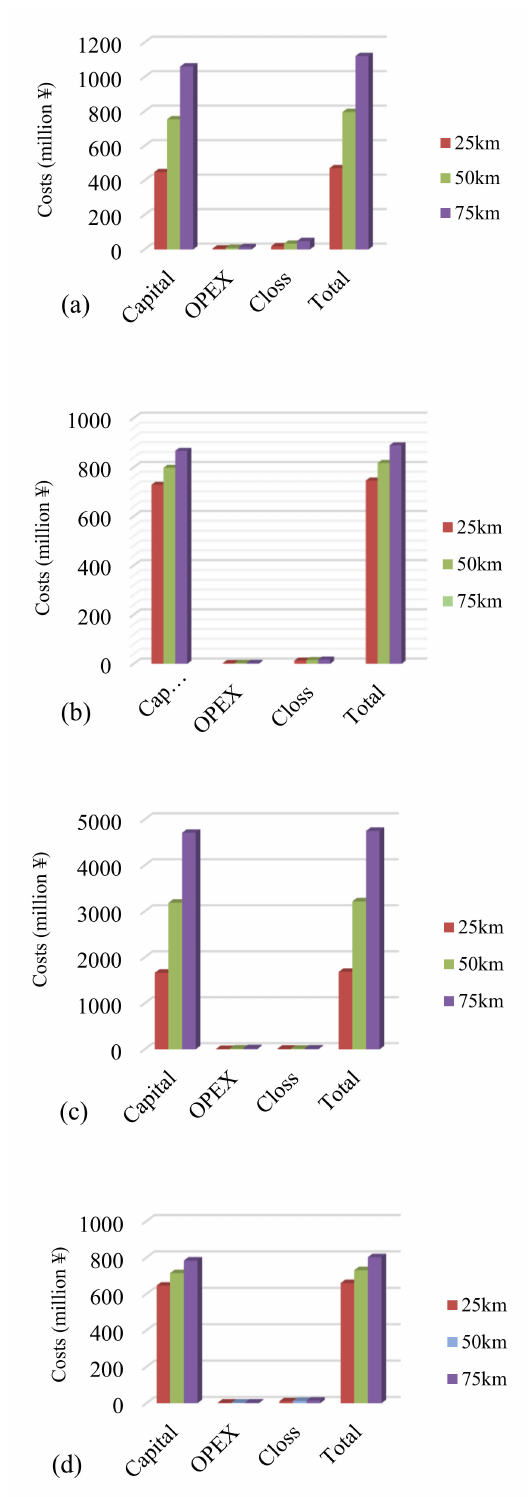
Figure 4. Cost component comparisons with different L ( P is 300 MW): ( a ) shows the HVAC system; ( b ) shows the VSC-HVDC system; ( c ) shows the GIL system; ( d ) shows the Hybrid HVDC